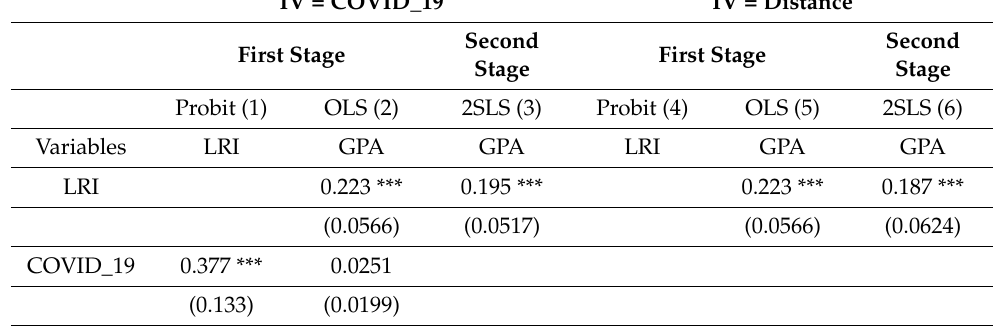
Table 4. Results of endogeneity treatment for LRI and GPA regressions:2SLS model. IV = COVID_19 IV = Distance